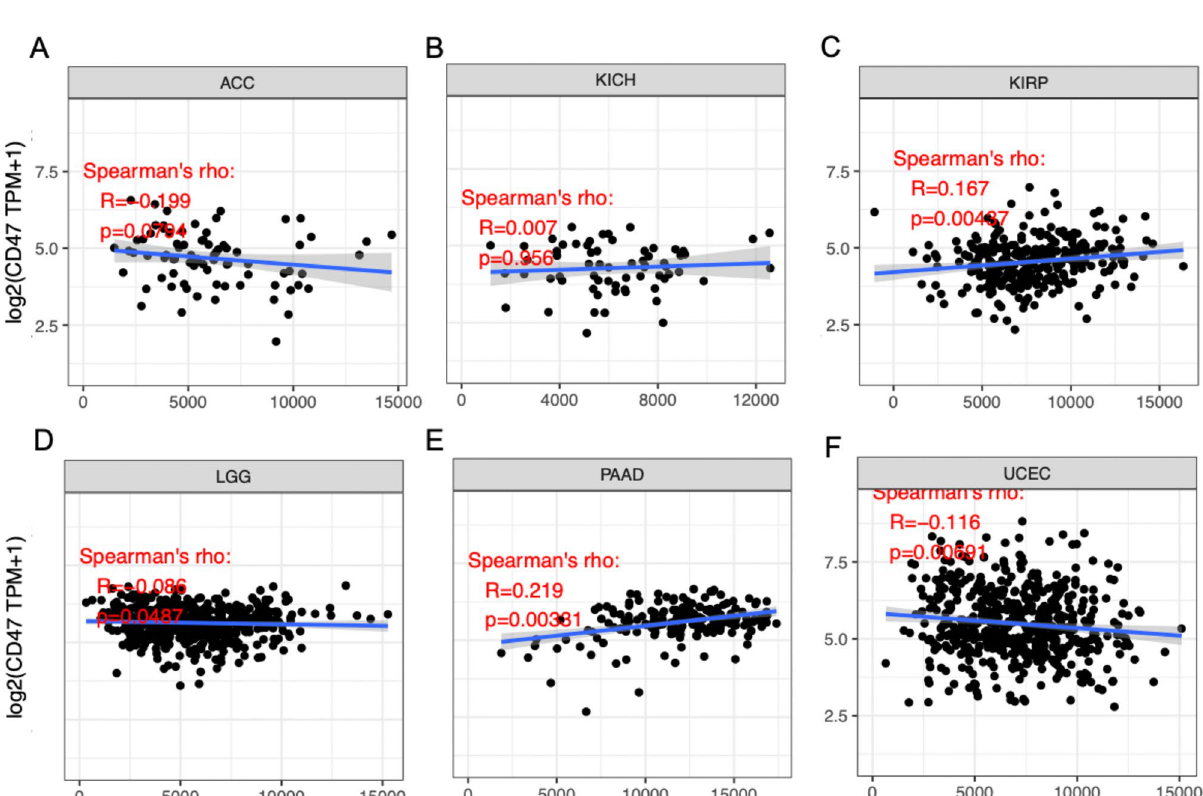
Figure 4. Correlation of CD47 expression with Estimate Score in ACC, KICH, KIRP, LGG, PAAD, UCEC ( A – F ). The level of CD47 expression was inversely related to tumor purity in LGG, and positively correlated with tumor purity in KIRP,